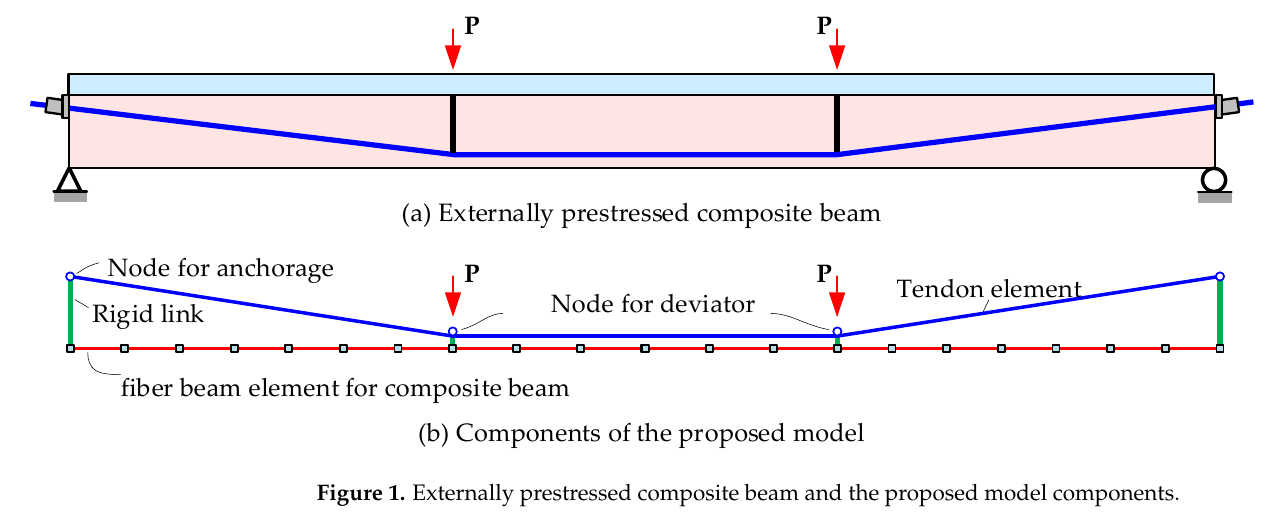
Figure 1. Externally prestressed composite beam and the proposed model components.